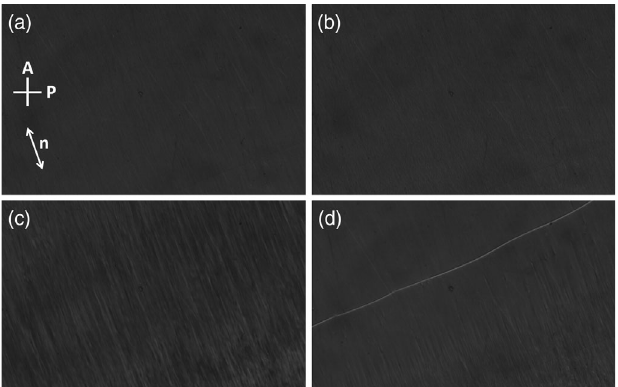
FIG. 2. Polarization microscopy images showing the N - N S phase transition at a cooling rate of 0 . 1 K = min in a planar cell (thickness 20 μ m). (a) Homogeneously oriented sample in the N phase, (b) strong splay fluctuations just above the N - N phase S transition, (c) destabilization of the homogeneous orientation during the transition, and (d) restoration of the homogeneous order in the N phase. The orientation of n , polarizer P, and S analyzer A are shown in (a). For better observations, the sample was rotated so that the angle between n and the analyzer was around 20°. The width of the images is 545 μ